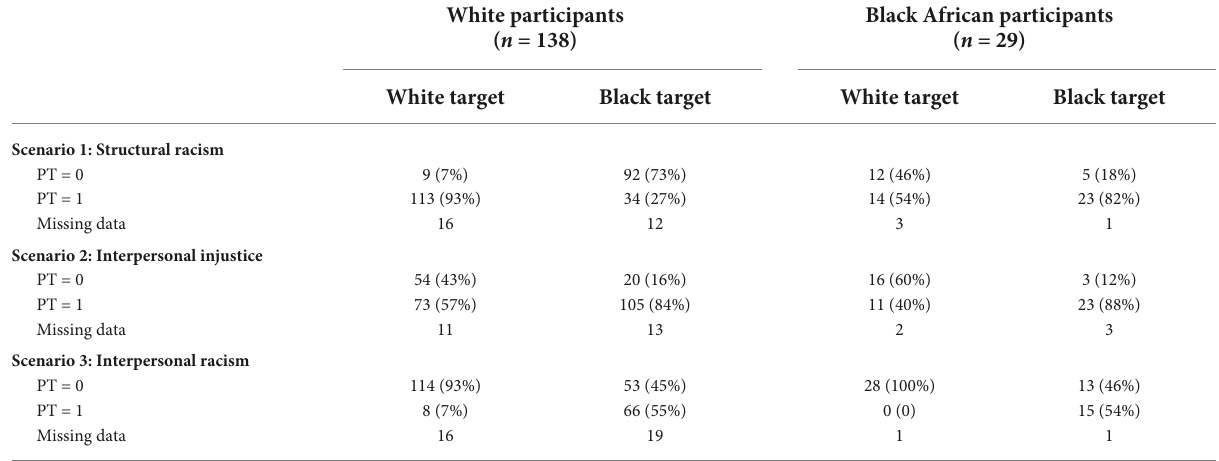
TABLE 1 Perspective taking frequency scores: Study 2.